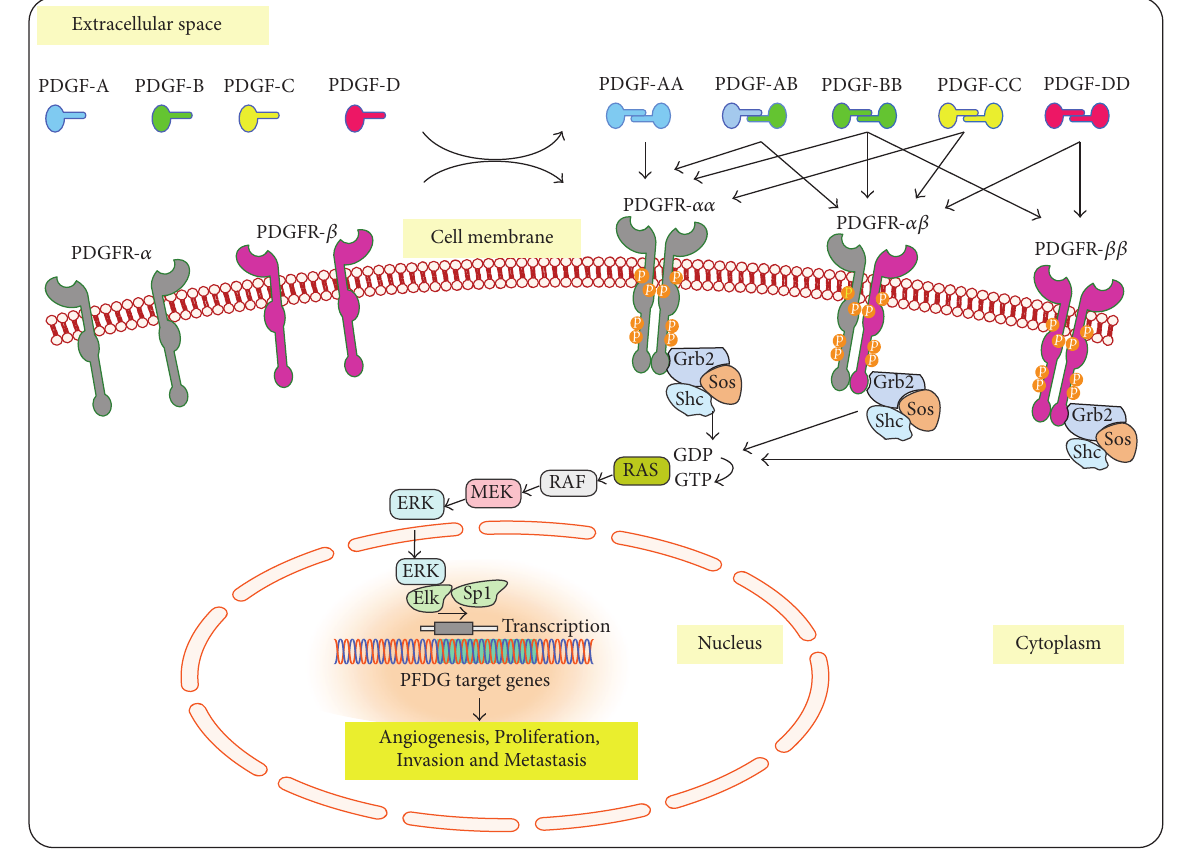
Figure 1: The family of platelet-derived growth factors (PDGFs) and their receptors (PDGFRs) and their functions. Five specific ligands isoforms (PDGF-AA, PDGF-AB, PDGF-BB, PDGF-CC, and PDGF-DD) interact with three of their receptors dimers (PDGFR- 𝛼𝛼 , PDGFR- 𝛼𝛽 , and PDGFR- 𝛽𝛽 ) and initiate a complex MAP-kinase signaling cascade that activates specific genes involved in angiogenesis, proliferation, invasion, and